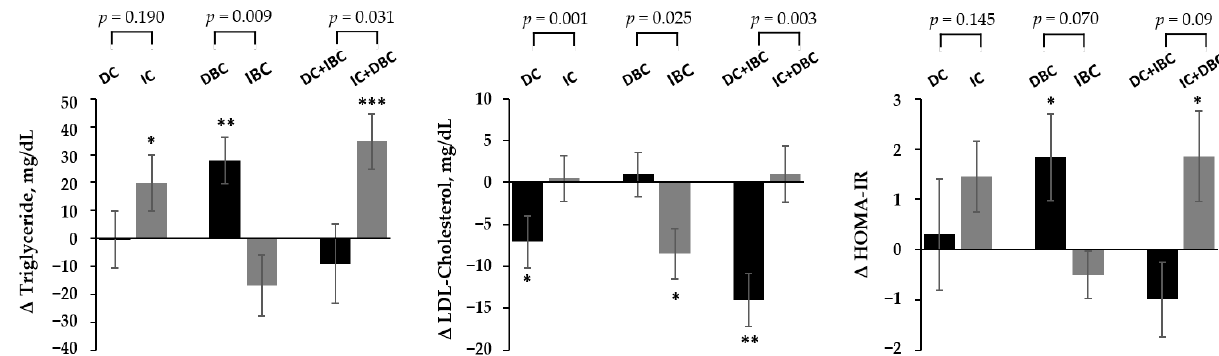
Figure 1. Changes in metabolic parameters by target metabolites group after lifestyle intervention. p -values were calculated using ANCOVA after adjustment for age, sex, baseline BMI z-score, values for the respective outcome traits at baseline to compare differences of between-groups at 6 months. Paired t -test was used to compare difference between pre-intervention (0 M) and post-intervention (6 months) within each group, and p -values less than 0.05 are marked with asterisks (* p < 0.05, ** p < 0.01, *** p < 0.001). DC, decreased choline group; IC, increased choline group; DBC, decreased betaine/choline group IBC, increased betaine/choline group.